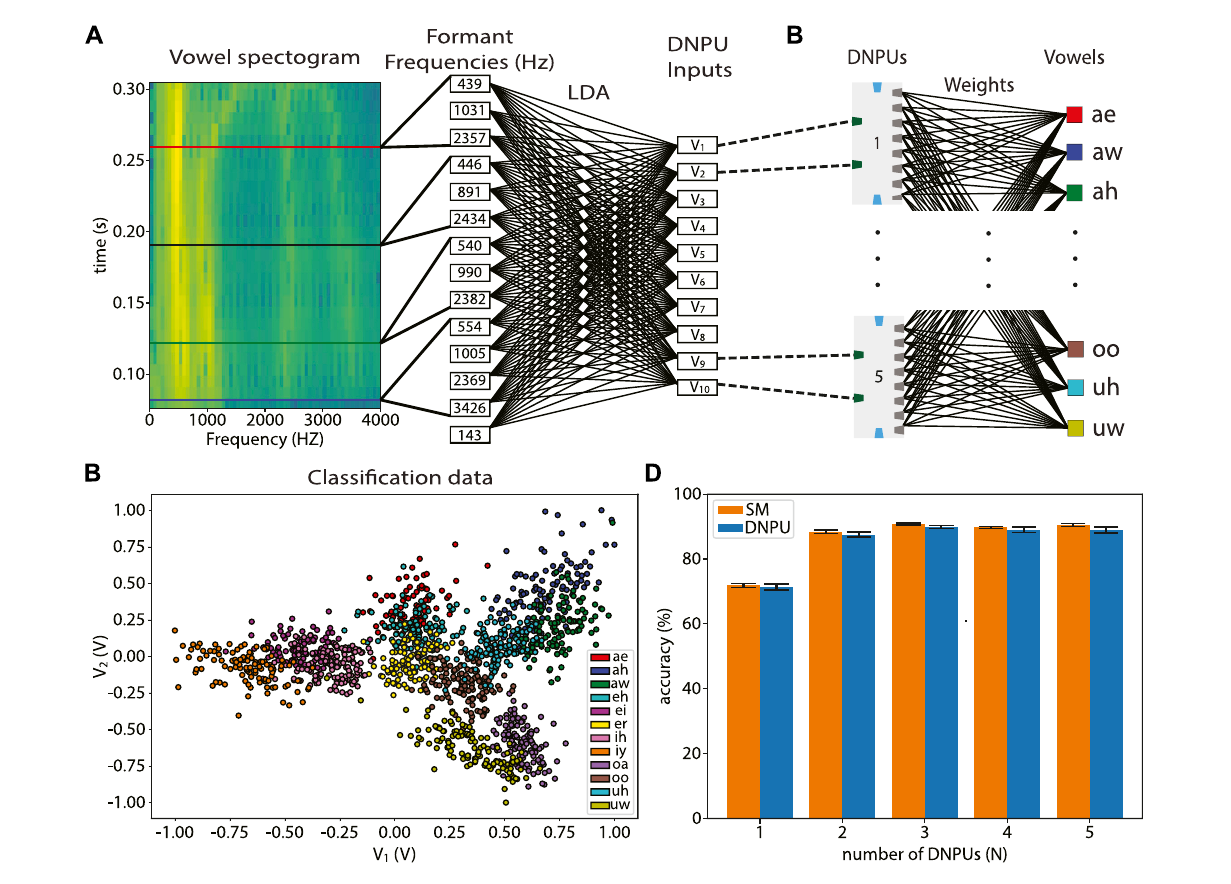
FIGURE 4 Spoken vowel recognition task: (A) Left: spectrogram of an adult male pronouncing “ oa ” . The horizontal lines indicate the times at which the formantsareextracted.Right:mappingofformantfrequenciestovoltagesV 1 -V 10 usinglineardiscriminantanalysis(LDA). (B) V 2 versus V 1 forall12vowels, showingoverlap, especiallyforV 2 . (C) Vowelclassi fi cation byNDNPUsinparallel, withalinear readoutlayer:V 1 andV 2 are inputstoDNPU 1 ,V 3 and V 4